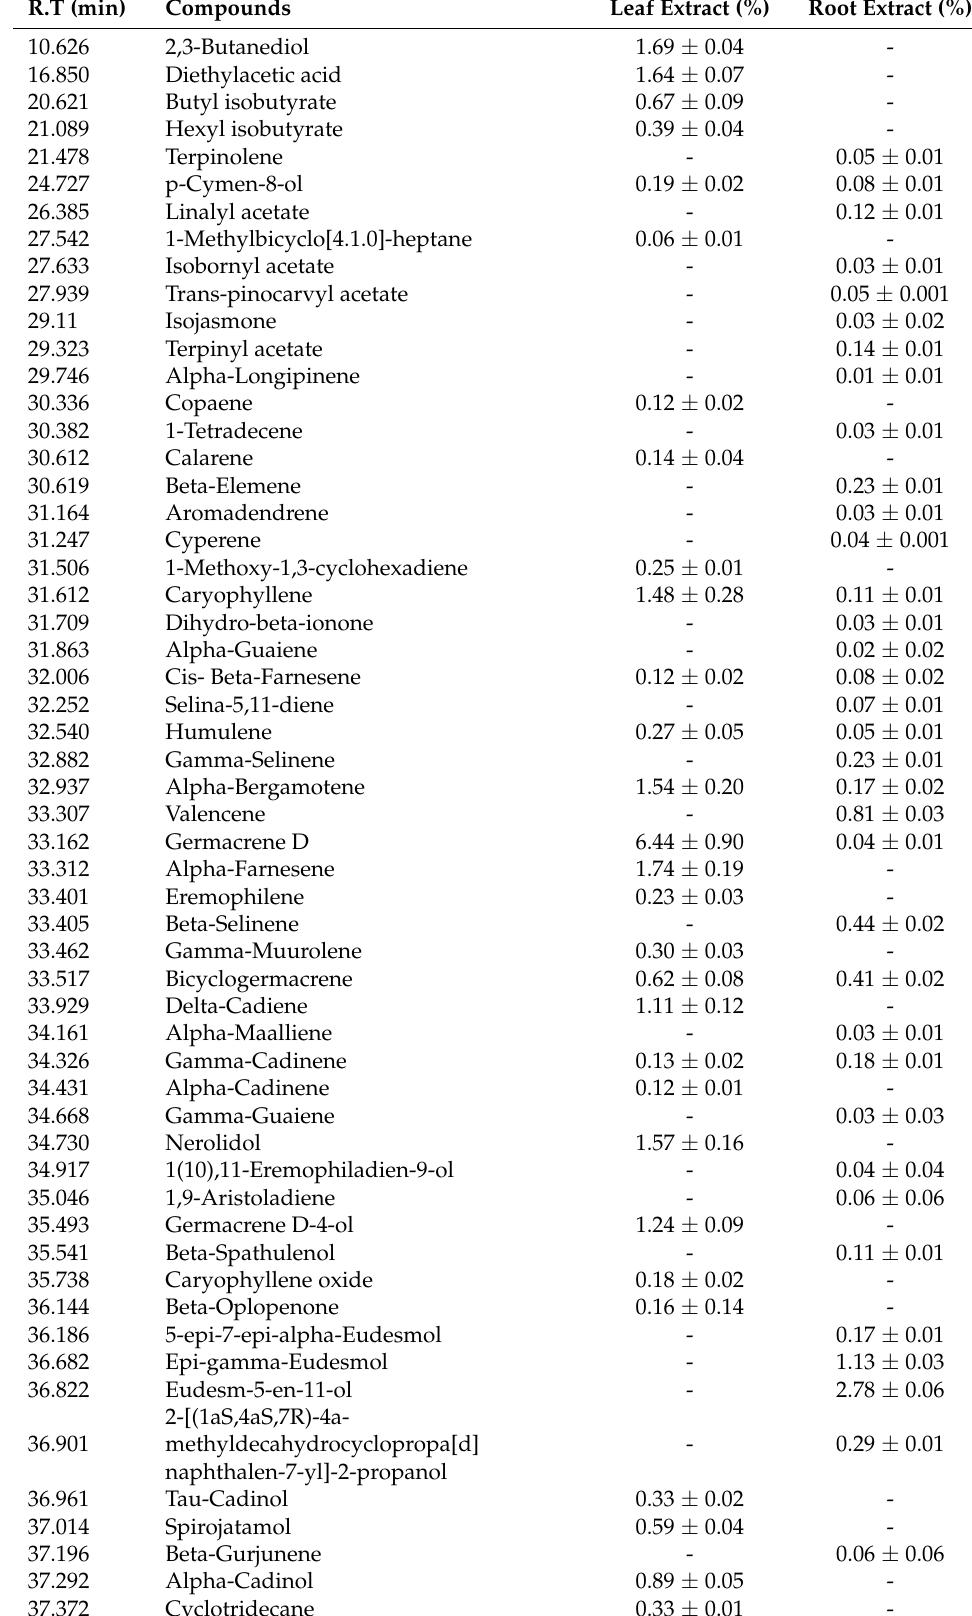
Table 2. Chemical composition of L. fischeri root and leaf extracts analyzed by